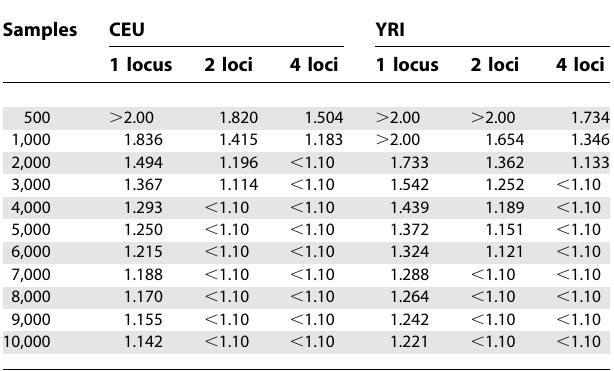
Table 3. Minimum Risk Detectable at a p- Value (cid:3) 0.05 after a Bonferroni Correction for Multiple Testing ( v 2 ‡ 28.5687 for CEU and v 2 ‡ 28.8976 for YRI) with 80% Power under the